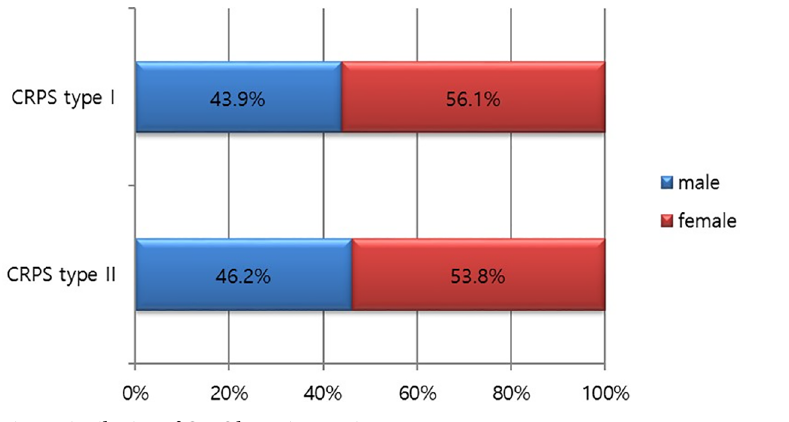
Fig 4. Distribution of CRPS by patient sex in 2015.